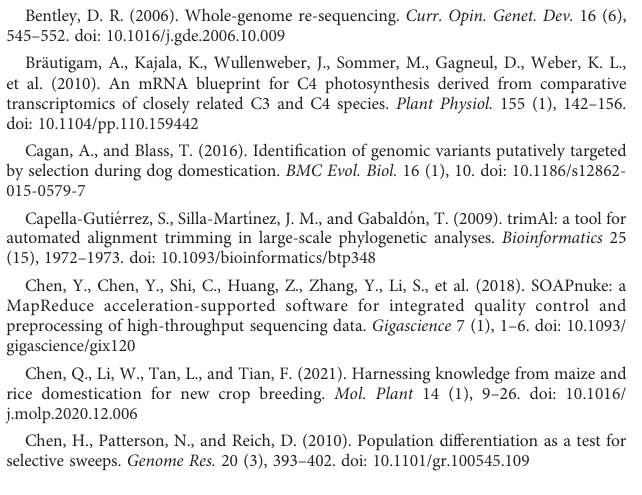
SUPPLEMENTARY FIGURE 1 The fl owchart for transcriptome-based SNP calling, phylogeny analysis and selection signals identi fi cation.